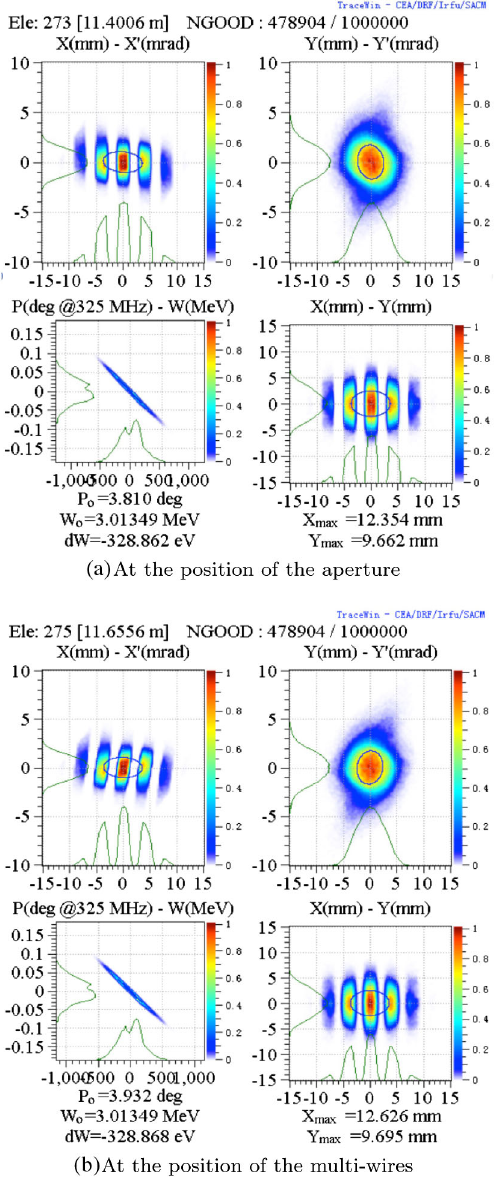
FIG. 11. Phase space and transverse profile of the proton beam at the positions of the aperture and multi-wires simulated by the T RACE W IN code.